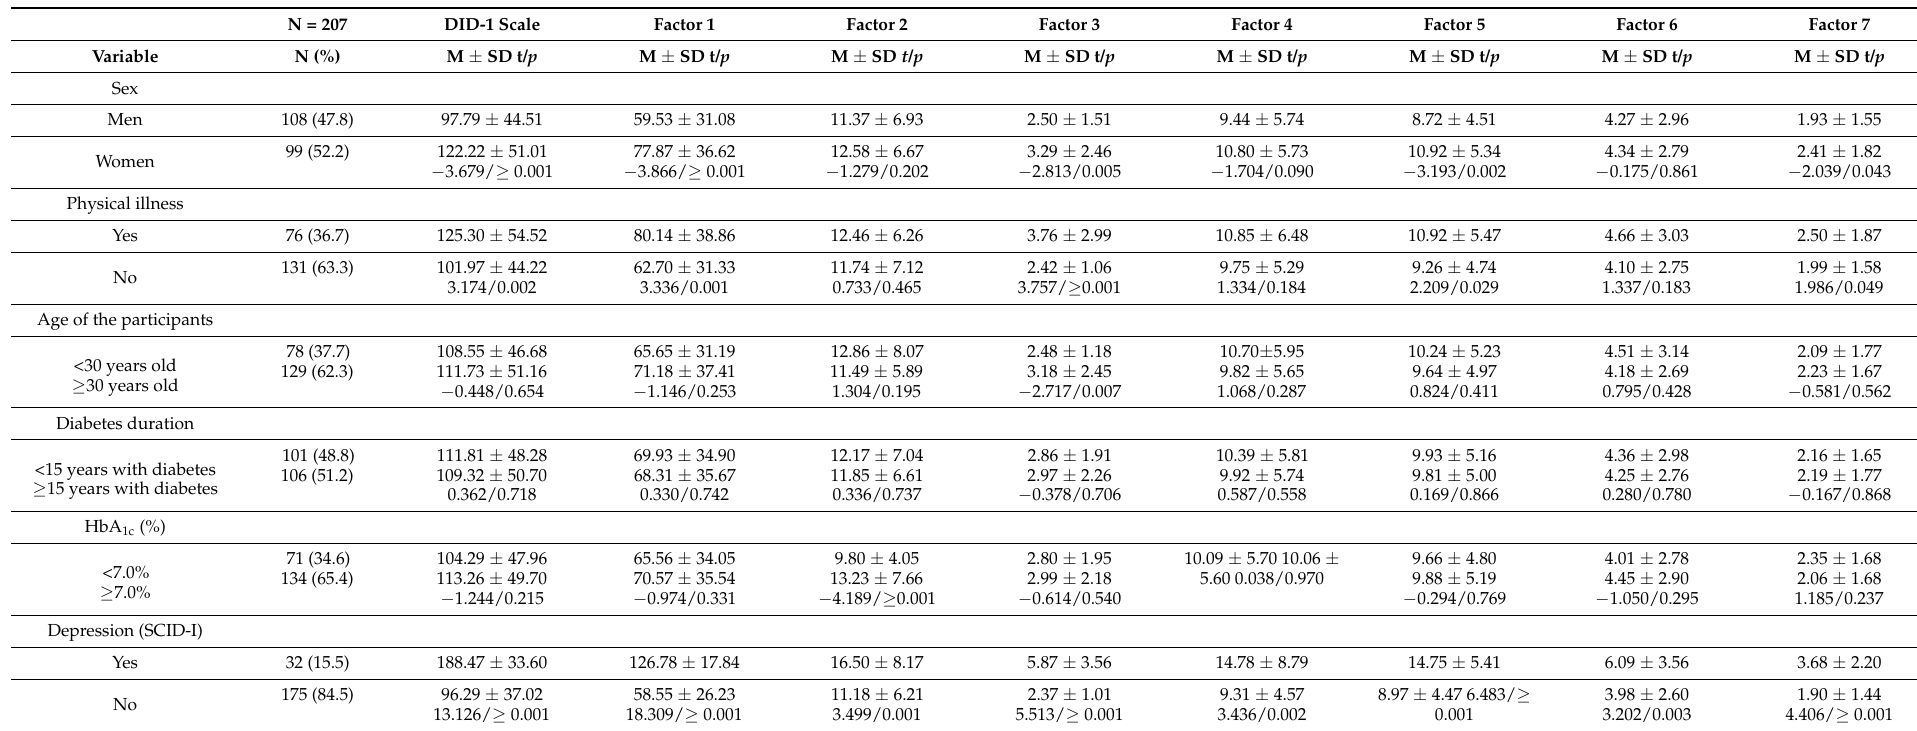
Table 4. Differences in the scores on the DID-1 scale and in the seven factors according to the characteristics of the